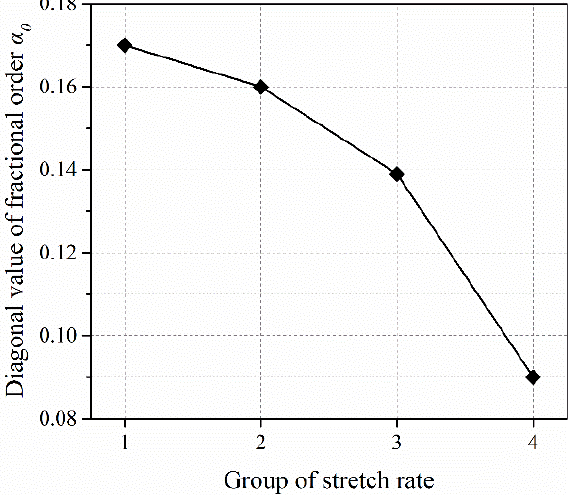
Figure 2. The obtained variance of fractional order at four different stretch rates, (1) 20/min, (2) 50/min, (3) 200/min, (4) 500/min.